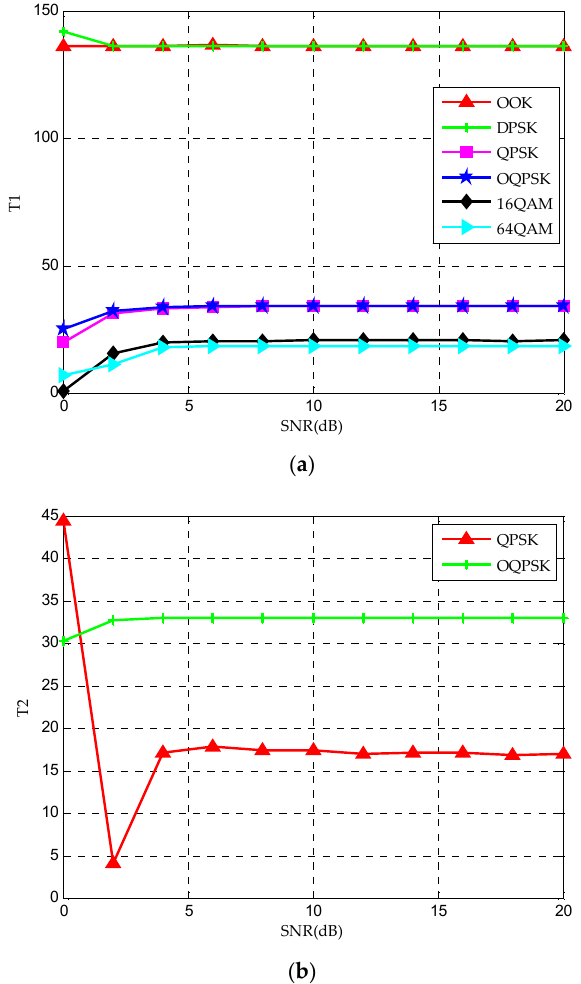
Figure 3. The values of feature parameters ( a ) T1 and ( b ) T2 under different signal-to-noise ratios (SNRs).